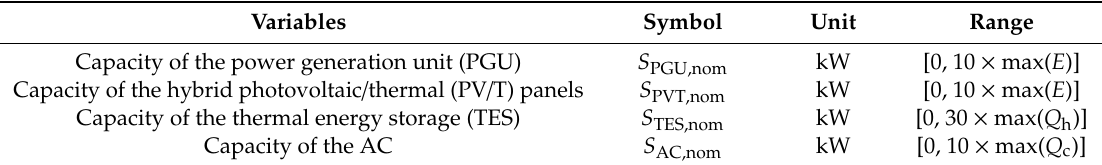
Table 1. The range of variations of the decision